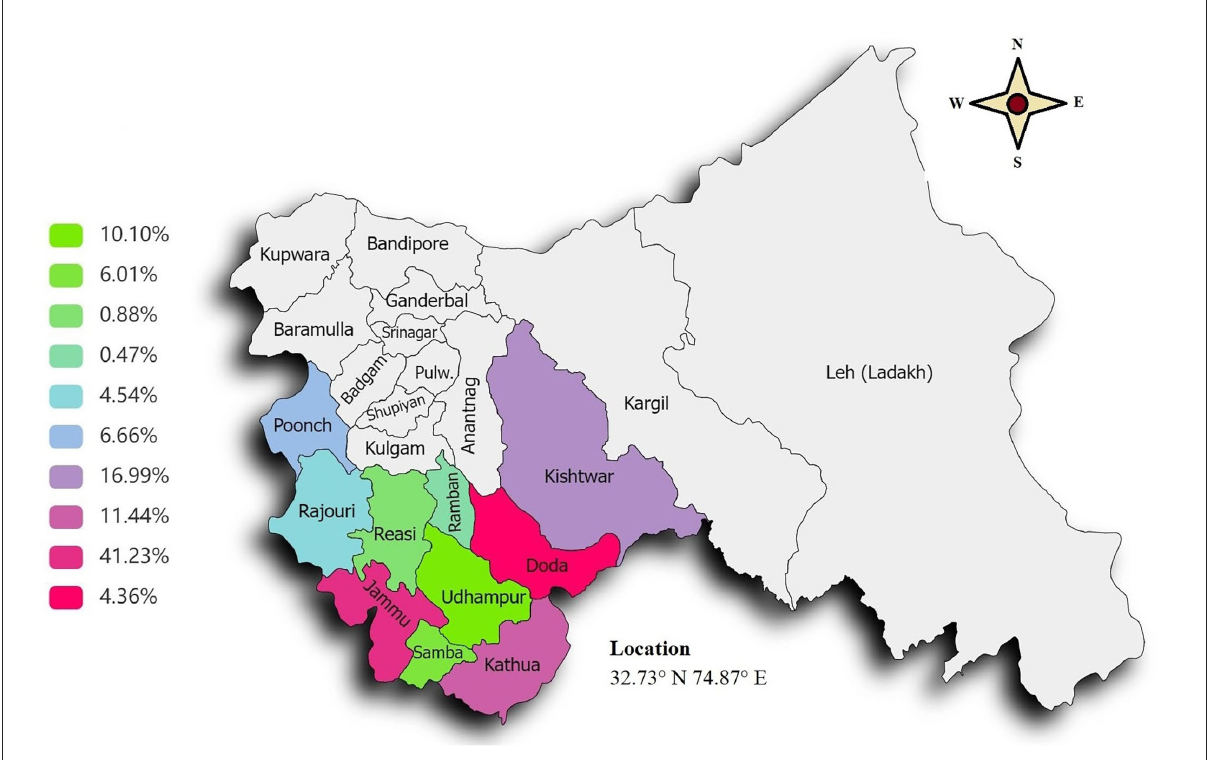
FIGURE5 Prevalence of headaches in the Jammu region of the north Indian